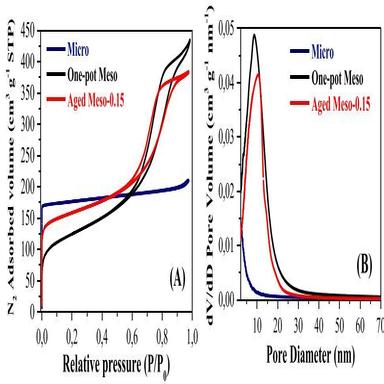
. (A) N2 adsorption/desorption isotherms of conventional microporous and micro-mesoporous CHA-based zeolites and (B) BJH pore diameter distributions of hierarchical CHA-based zeolites.